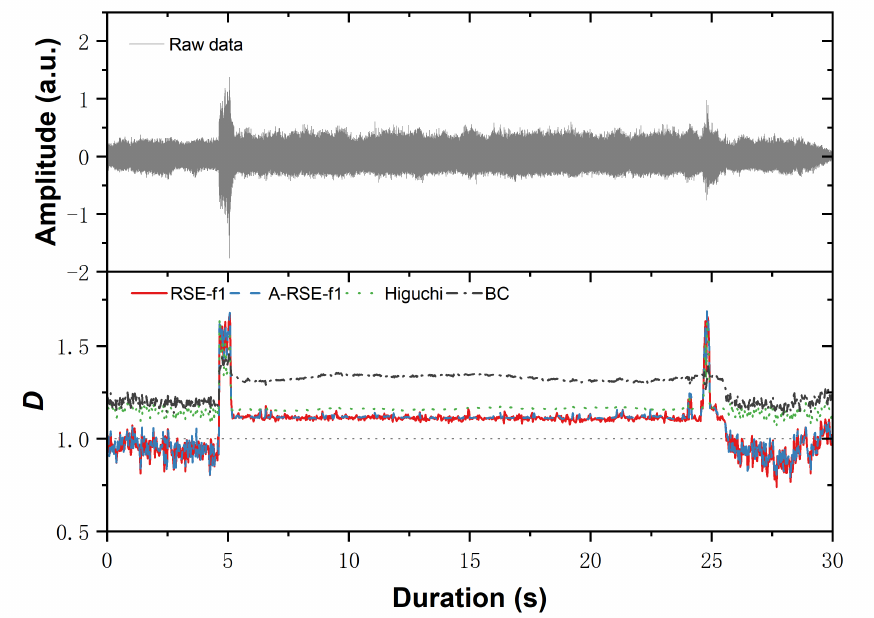
Figure 9. The acceleration signals of stable milling and D values of signal calculated by RSE-f1, A-RSE-f1, Higuchi, and BC algorithms.